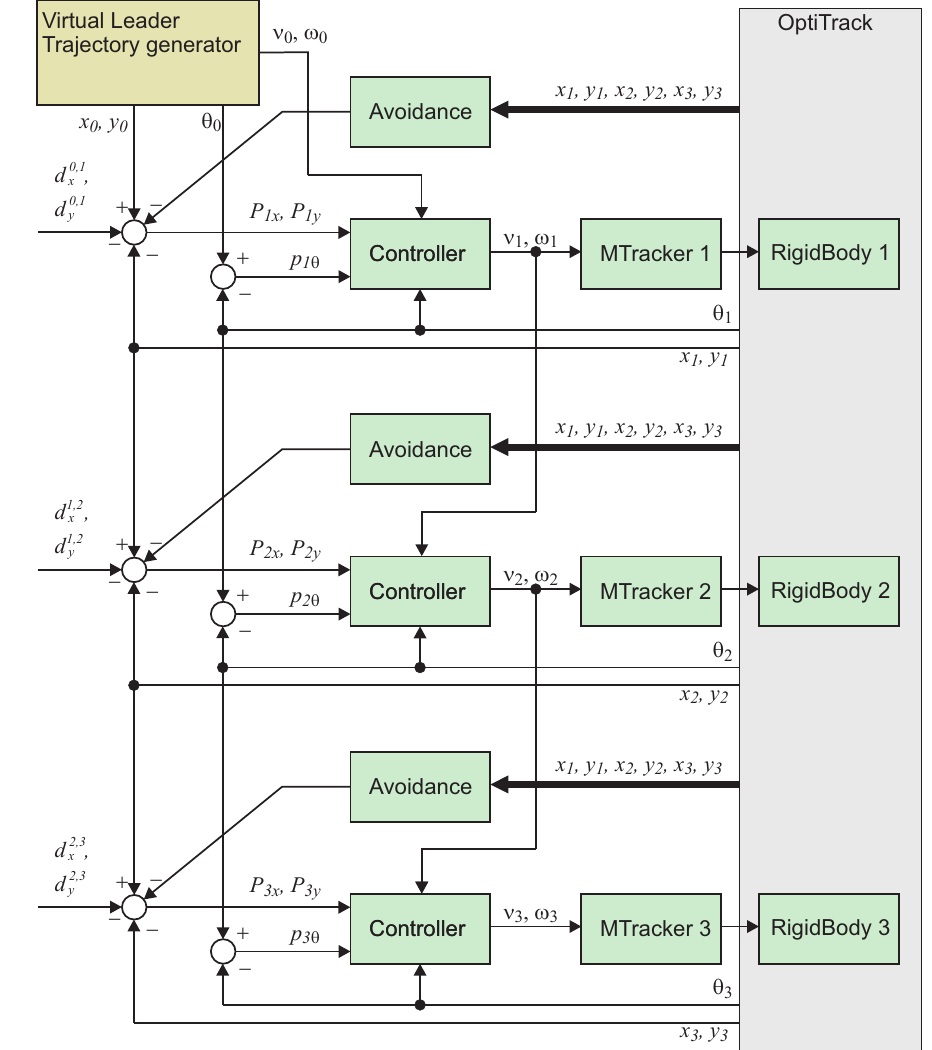
Figure 5. Functional block scheme of the control system.